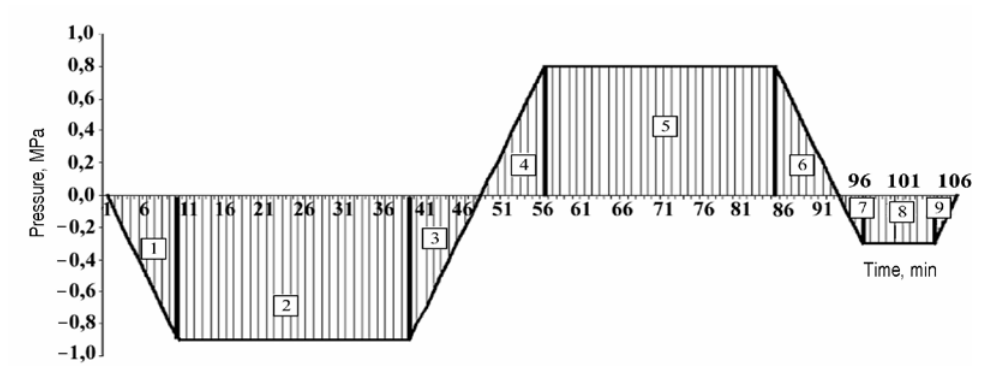
Fig 1. Saturation process with a salt-containing agent